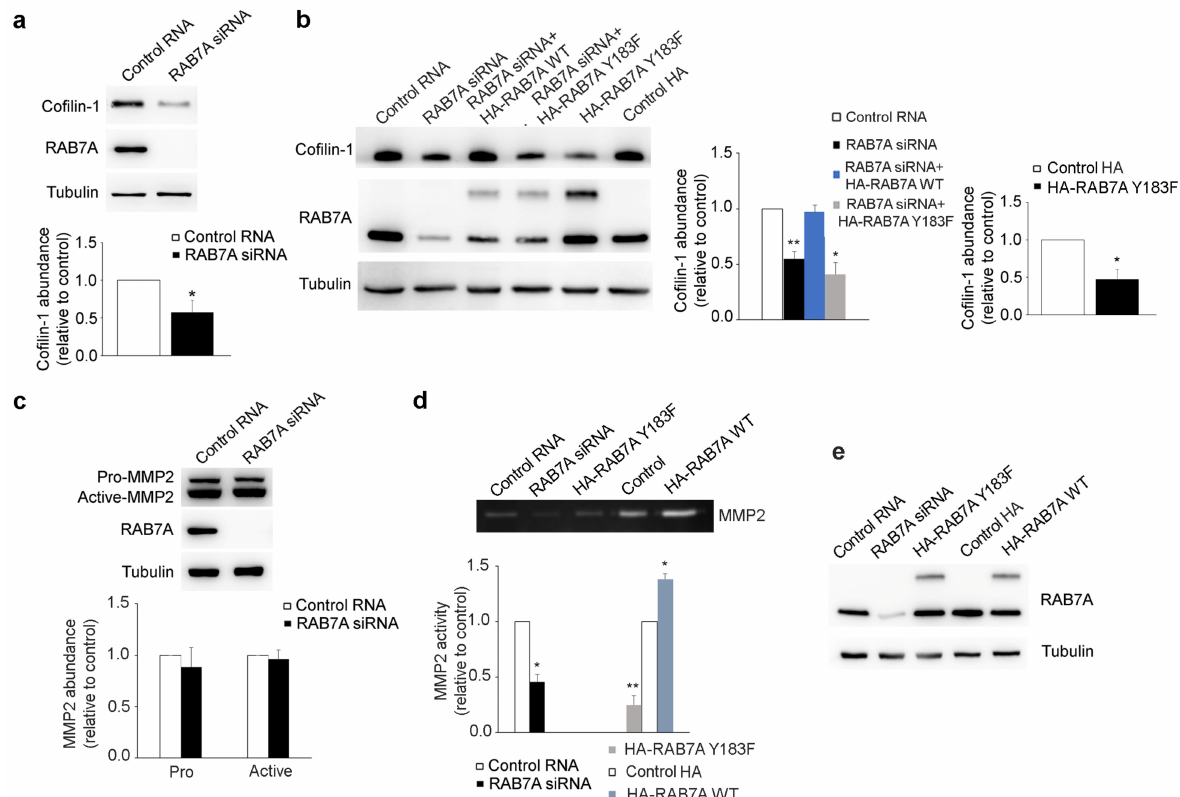
Figure 7. RAB7A regulates cofilin-1 abundance and matrix metalloproteinase 2 (MMP2) activity. ( a ) HeLa cells were transfected with either control RNA or RAB7A siRNA, replated 72 h after transfection and then lysed after 48 h. Lysates were subjected to Western blot analysis using the indicated antibodies. Quantification of cofilin-1 abundance is shown. ( b ) HeLa cells were treated with either control RNA or RAB7A siRNA or transfected with plasmids coding for HA or HA-RAB7A Y183F . HeLa cells silenced for RAB7A were also transfected with plasmids encoding HA-RAB7A WT or Y183F to rescue RAB7A functions. Lysates were subjected to Western blot analysis using the indicated antibodies. Quantification of cofilin-1 abundance is shown. ( c ) HeLa cells were transfected with either control RNA or RAB7A siRNA, replated 72 h after transfection and then lysed after 48 h. Lysates were subjected to Western blot analysis using anti-MMP2, anti-tubulin, and anti-RAB7A antibodies. Quantifications of pro-MMP2 and active-MMP2 abundance are shown. ( d ) gelatin zymography was performed using conditioned medium of HeLa cells treated with either control RNA or RAB7A siRNA or transfected with plasmids encoding HA, HA-RAB7A WT , or HA-RAB7A Y183F . Quantification of MMP2 activity is shown. ( e ) HeLa cells, treated with either control RNA or RAB7A siRNA or transfected with plasmids encoding HA, HA-RAB7A WT , or HA-RAB7A Y183F and whose conditioned medium was used for gelatin zymography, were lysed and lysates were subjected to Western blot analysis using anti-tubulin and anti-RAB7A antibodies. All data represent the mean ± s.e.m. of three independent experiments. * = p < 0.05; ** = p <